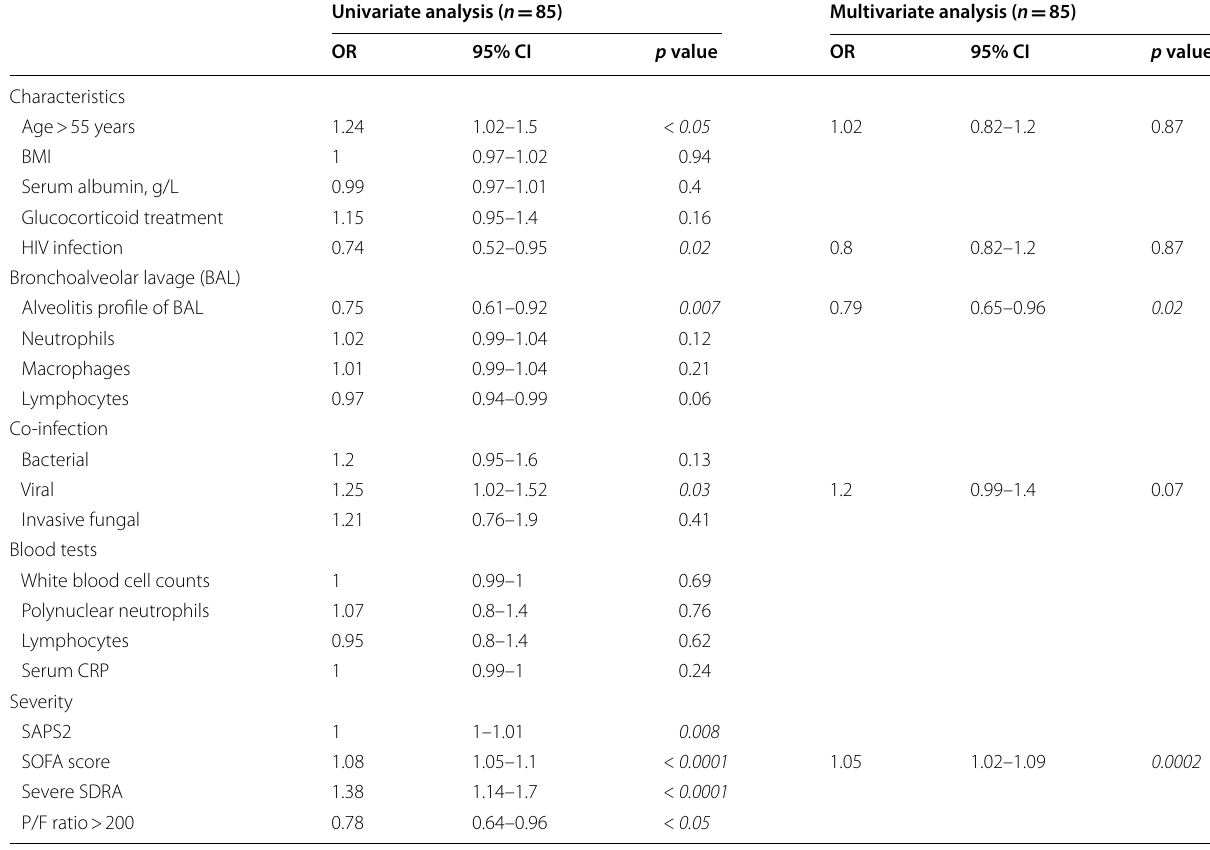
Italics characters correspond to the analysis parameters with a statistically significant difference BMI, body mass index; SAPS2, simplified acute physiology score version 2, SOFA score, sequential organ failure assessment score; HIV, human immunodeficiency